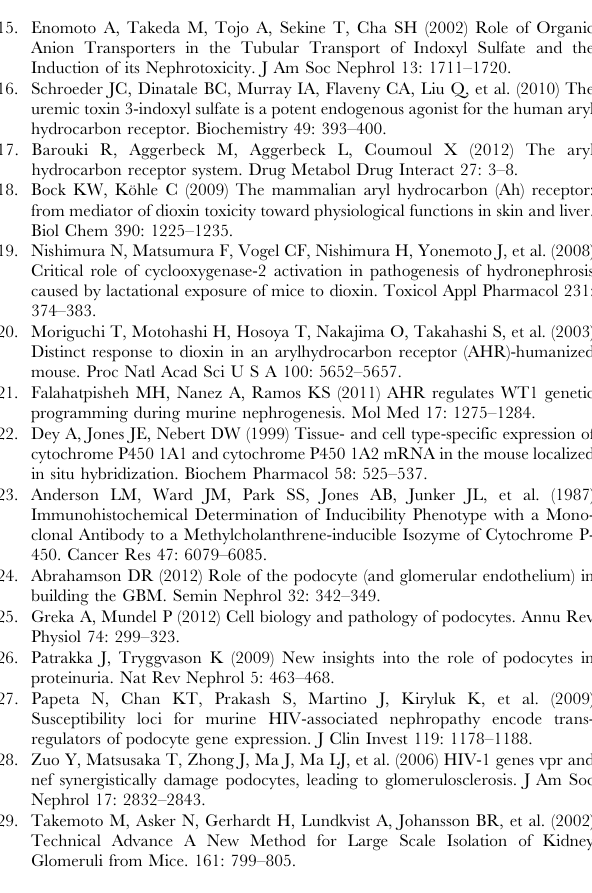
Figure S2 AhR knock-down altered the expression of